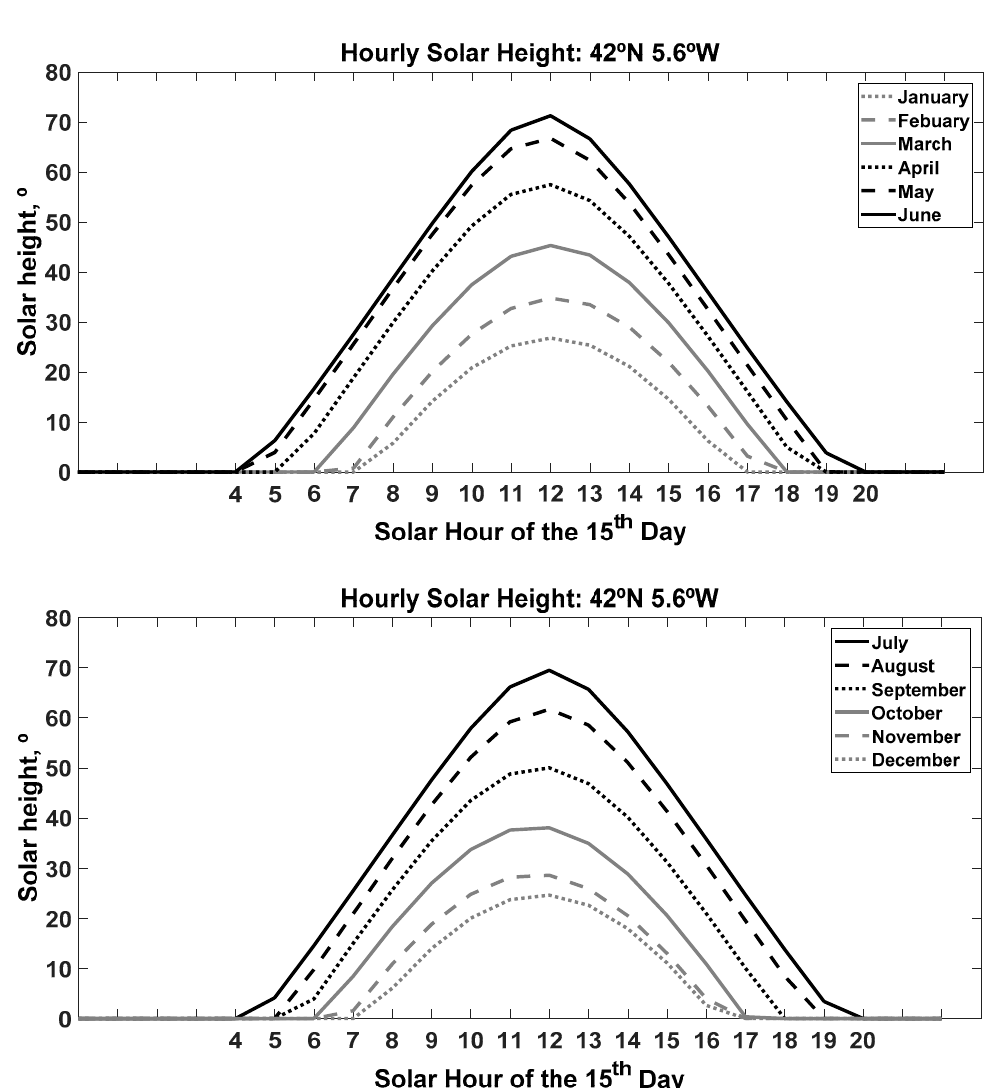
Figure 5. Hourly solar height calculated at latitude 42° N and longitude 5.6° W for the 15th day of each month. ( Top ) January to June; ( bottom ) July to December.